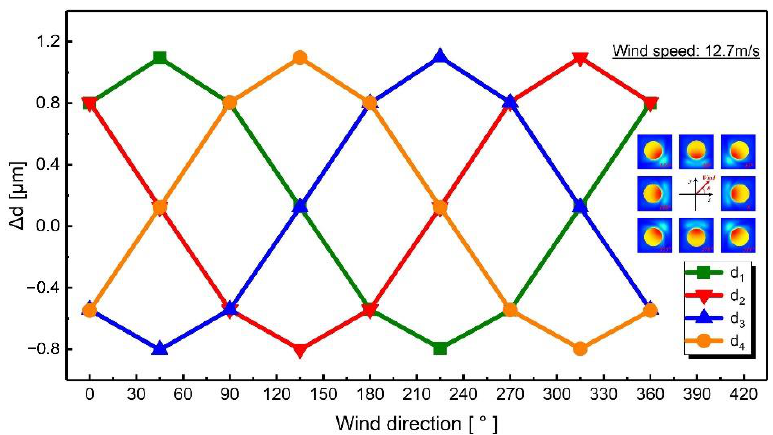
Figure 4. Simulated change in gap distance when the wind direction changed from 0° to 360° in the xy-plane with a fixed wind speed of 12.7 m/s.